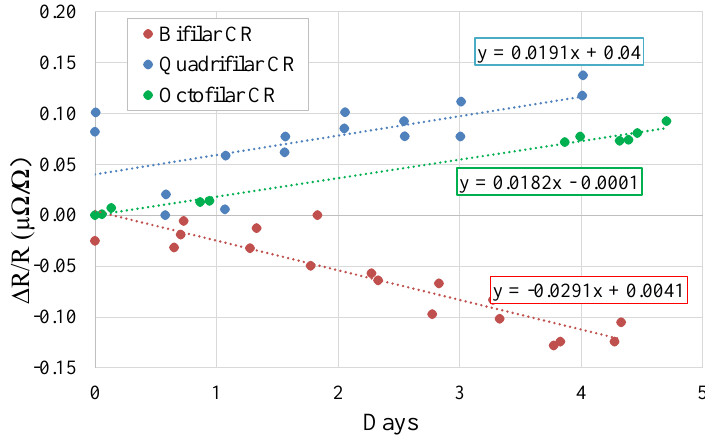
Figure 8. Short term stability of the bifilar, quadrifilar, and octofilar